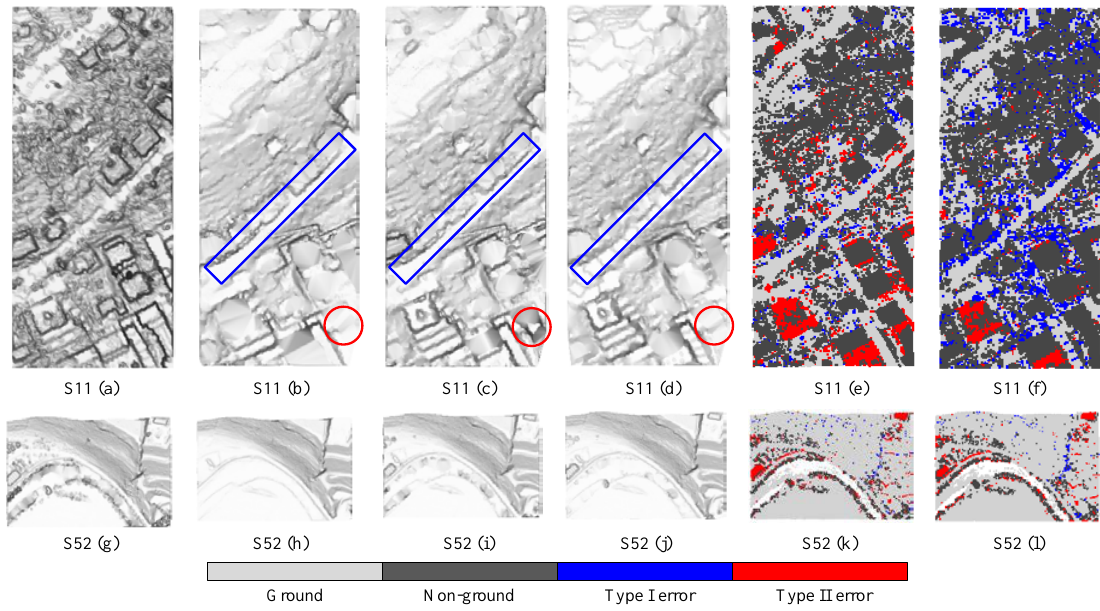
Figure 17. Results of each group (S11 and S52 are selected as representatives). First column: DSMs, second column: DTMs generated from the references, third column: DTMs produced by the proposed algorithm under CR = 0.5 m, fourth column: DTMs produced by the proposed algorithm under CR = 1 m, fifth column: spatial distributions of the type I and type II errors produced by the proposed algorithm under CR = 0.5 m, sixth column: spatial distributions of the type I and type II errors produced by the proposed algorithm under CR = 1 m.